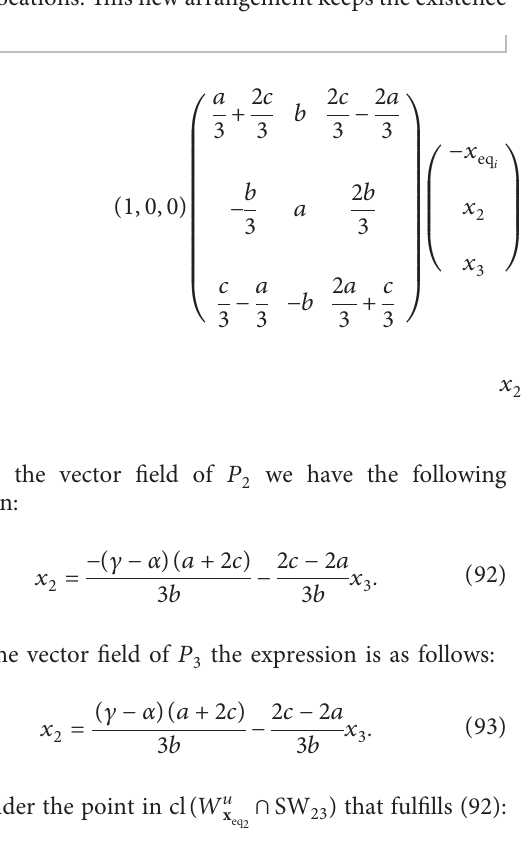
Figure 9: Seven trajectories of the system given by (1), (3), (5), (13), and (15) starting in R values of c : (a) c � 10 and (b) c �